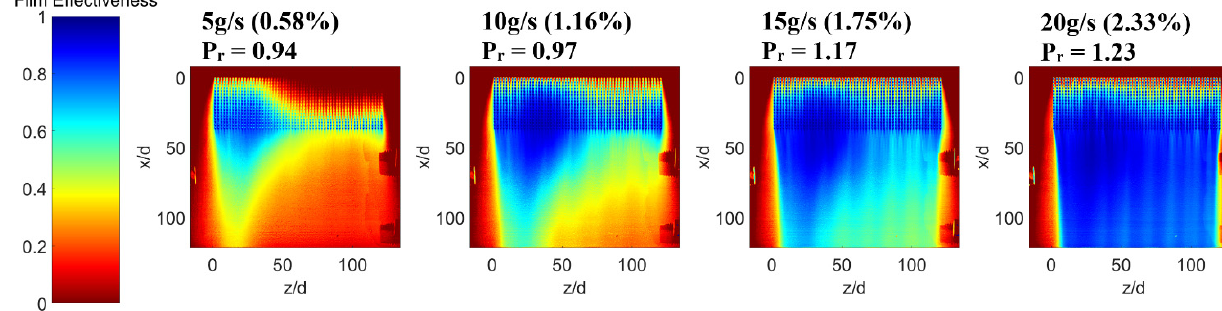
Figure 4. Film effectiveness of Panel 3 at different coolant mass flow rates (mass fraction).